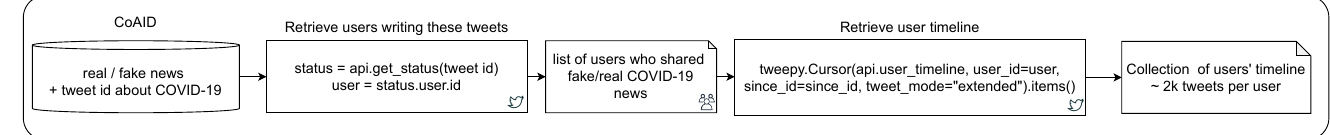
Figure 1. Spreader and checker timeline retrieval extending the CoAID